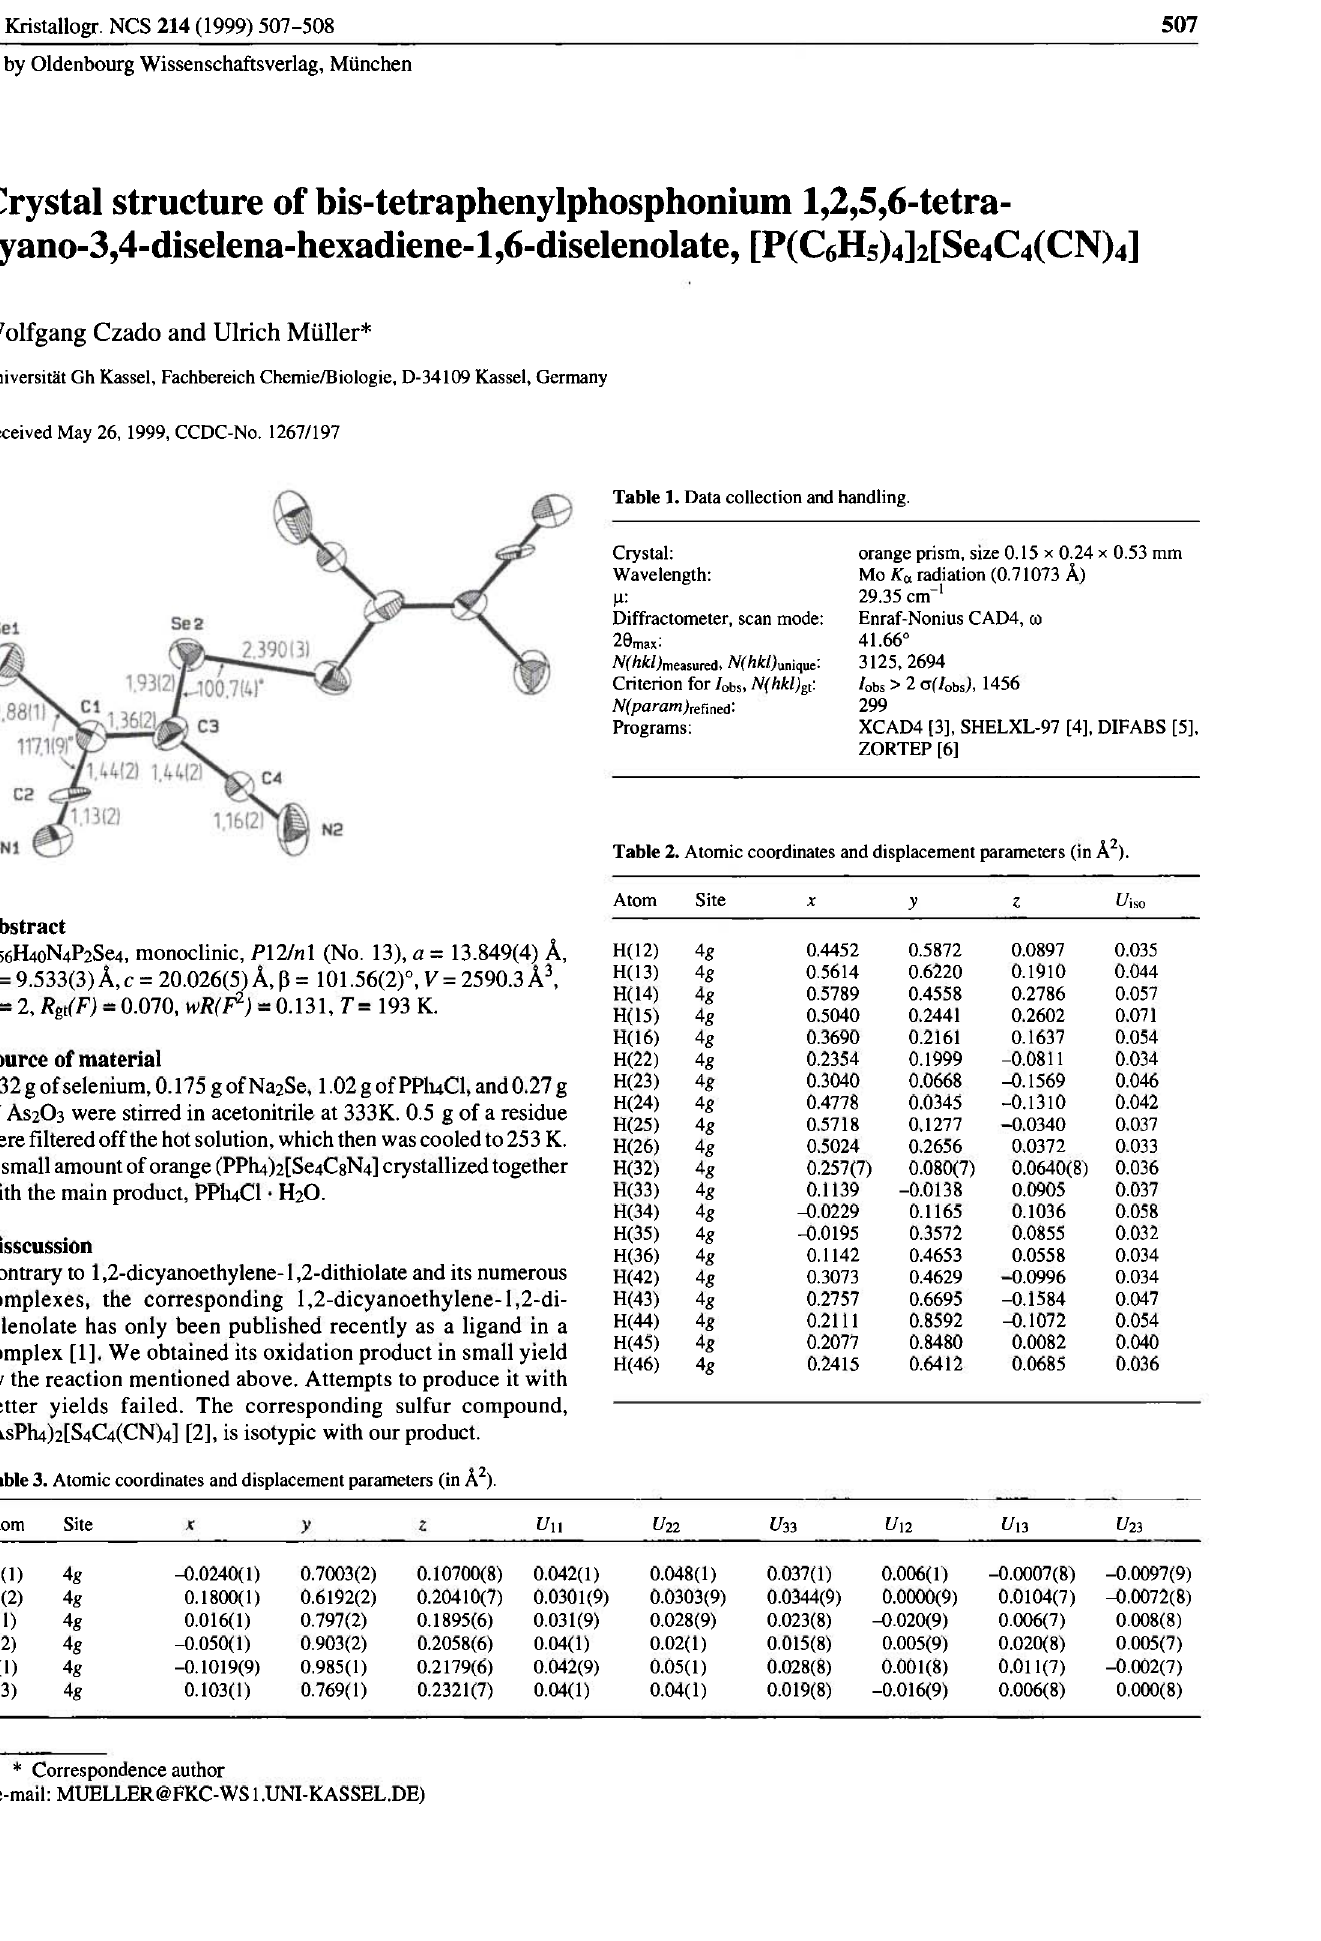
Table 1. Data collection and handling.